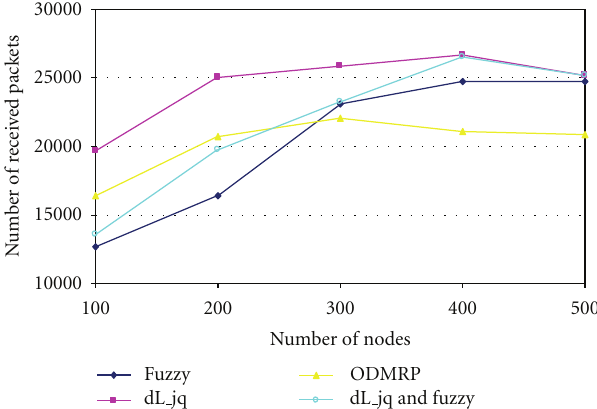
Figure 11: Life time with increasing speed of nodes.